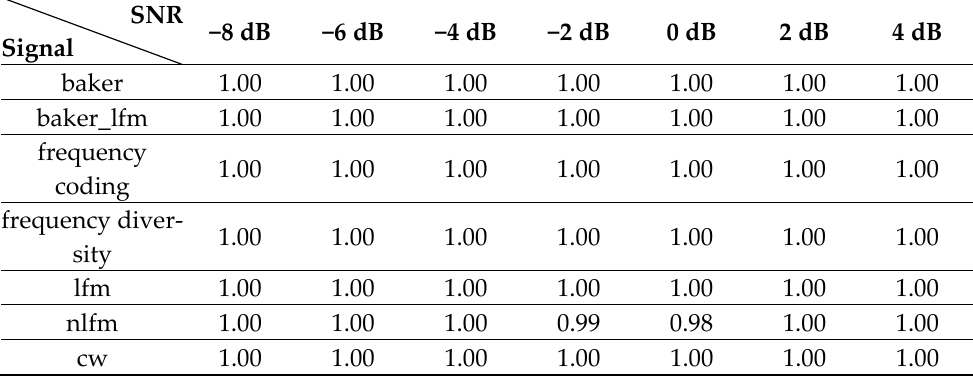
Table A3. Recognition results of one-dimensional DRSN under Poisson noise.